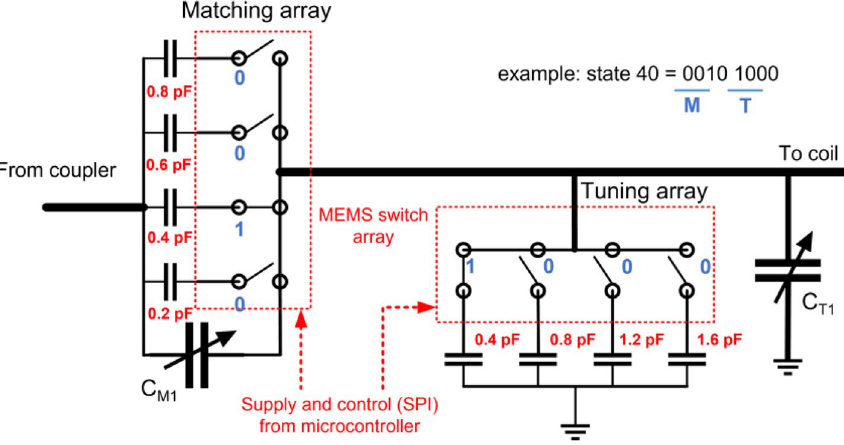
Figure 3. Matching network array design with individual fixed capacitor values and MEMS switches displaying one of the 256 combinations as an example to show individual MEMS switch configuration, where 0-switch off and 1-switch